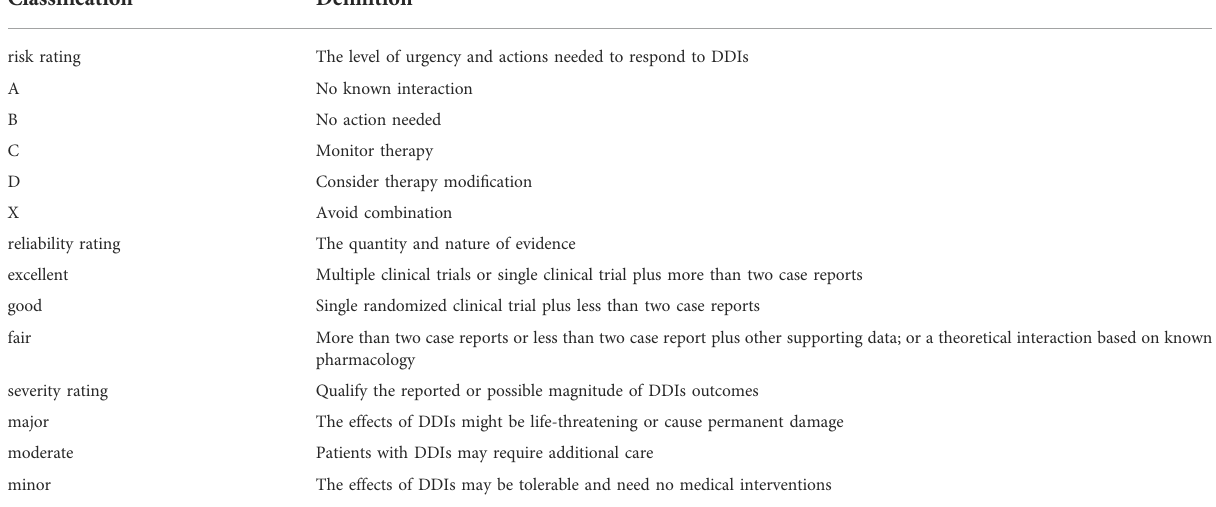
TABLE 1 De fi nitions of risk, reliability and severity ratings for DDIs by Lexi-Interact